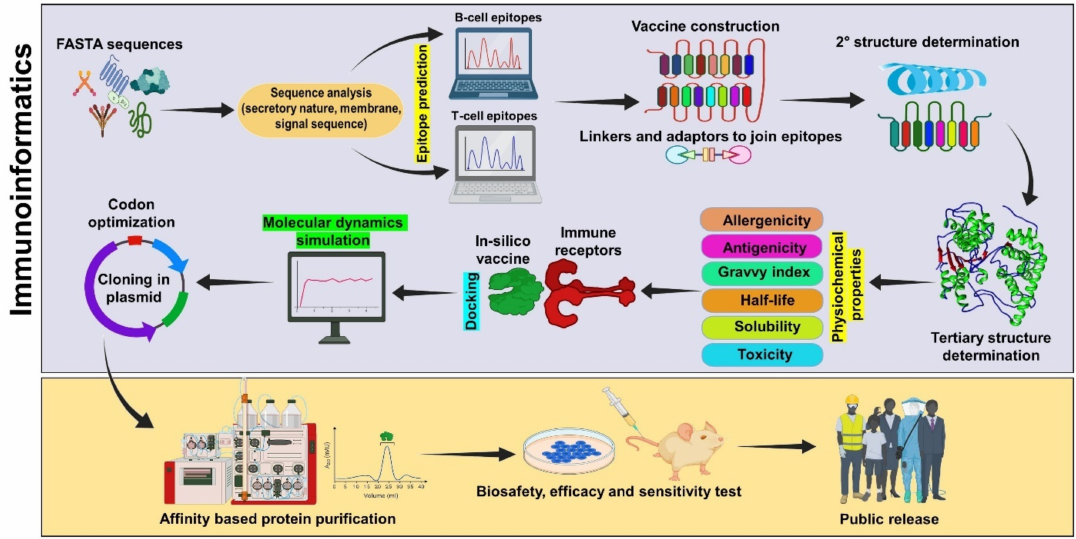
Figure 1. A detailed stepwise pipeline commonly used to construct a multi-epitope peptide vaccine through the immunoinformatics